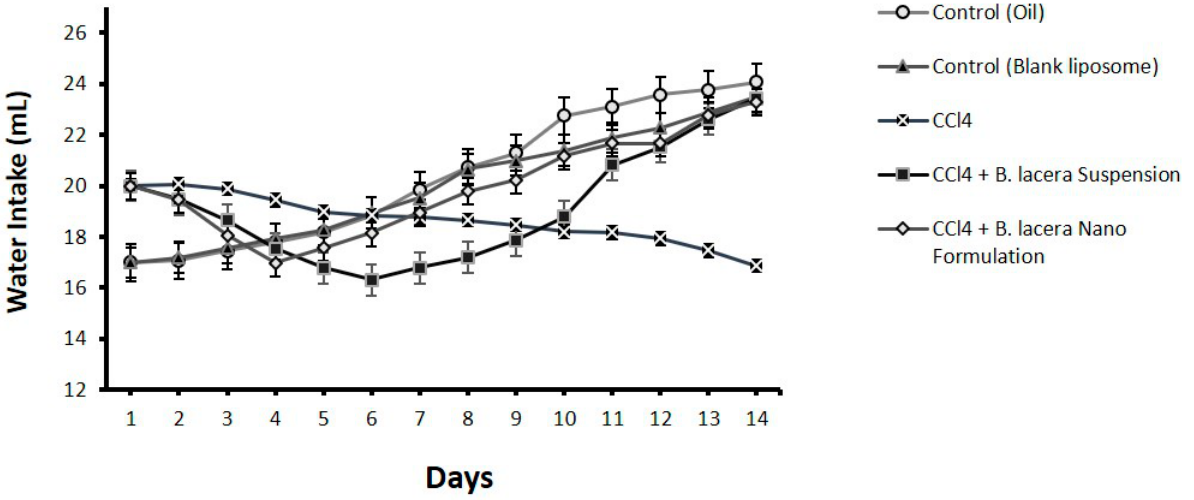
Figure 4. Effect of B. lacera leaf extract and its liposomal preparation on food intake of CCl 4 ‐ treated rats for14 days. Data are presented as mean ± standard error of mean, where n = 6.